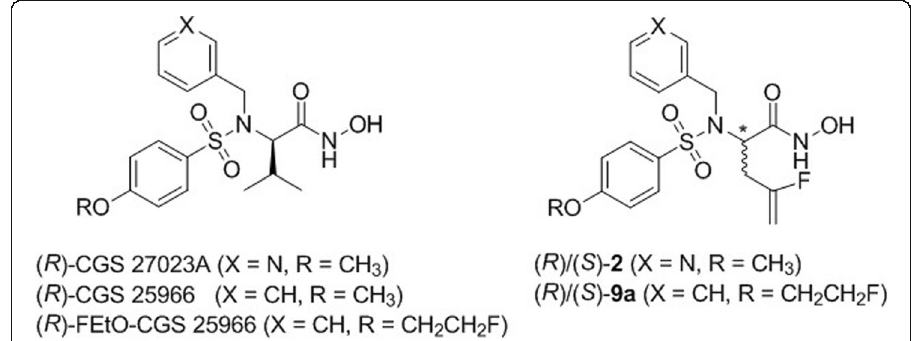
Fig. 2 CGS lead structures and γ -fluorinated α -sulfonylaminohydroxamic acids based MMP inhibitors 2